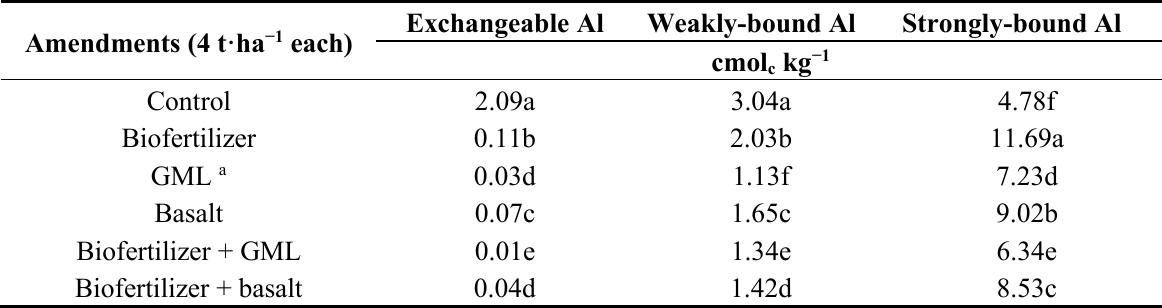
Table 5. Effects of bio-fertilizer, ground magnesium limestone (GML) and basalt application on the different forms of aluminum in soil after rice